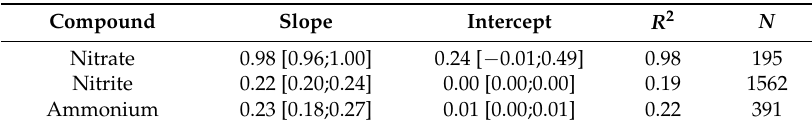
Table 2. Linear regression coefficients and 95% confidence intervals of nitrate and nitrite concentrations at exit waterworks versus within distribution system and consumers’ taps.